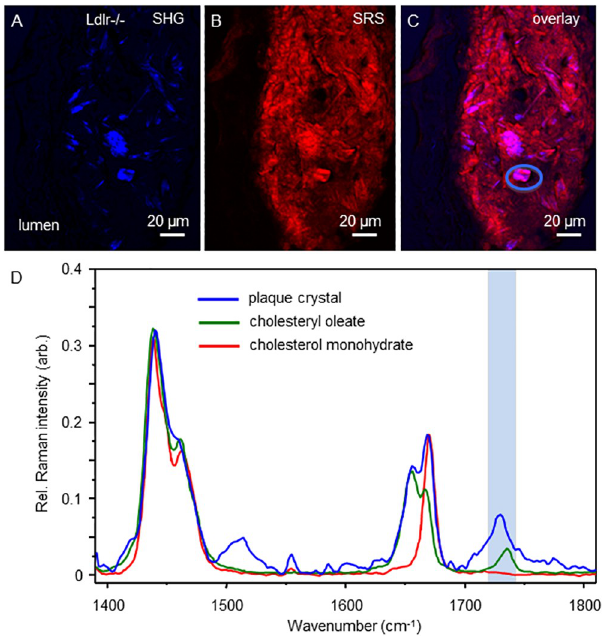
Fig 9. Hyperspectral scan of a Ldlr -/- plaque cuboidal CC detects a CE dominate signature. Top panels (A-C) show SHG, SRS and composite image of a lipid rich aorta plaque with a cuboidal crystalline region denoted (C, blue oval). Graphed below (D) is the spectral traces of the CC object (blue line) as well as standard traces of cholesteryl oleate (green) and free cholesterol monohydrate (red). The finger print region of the traces in the graph is highlighted (blue rectangle).